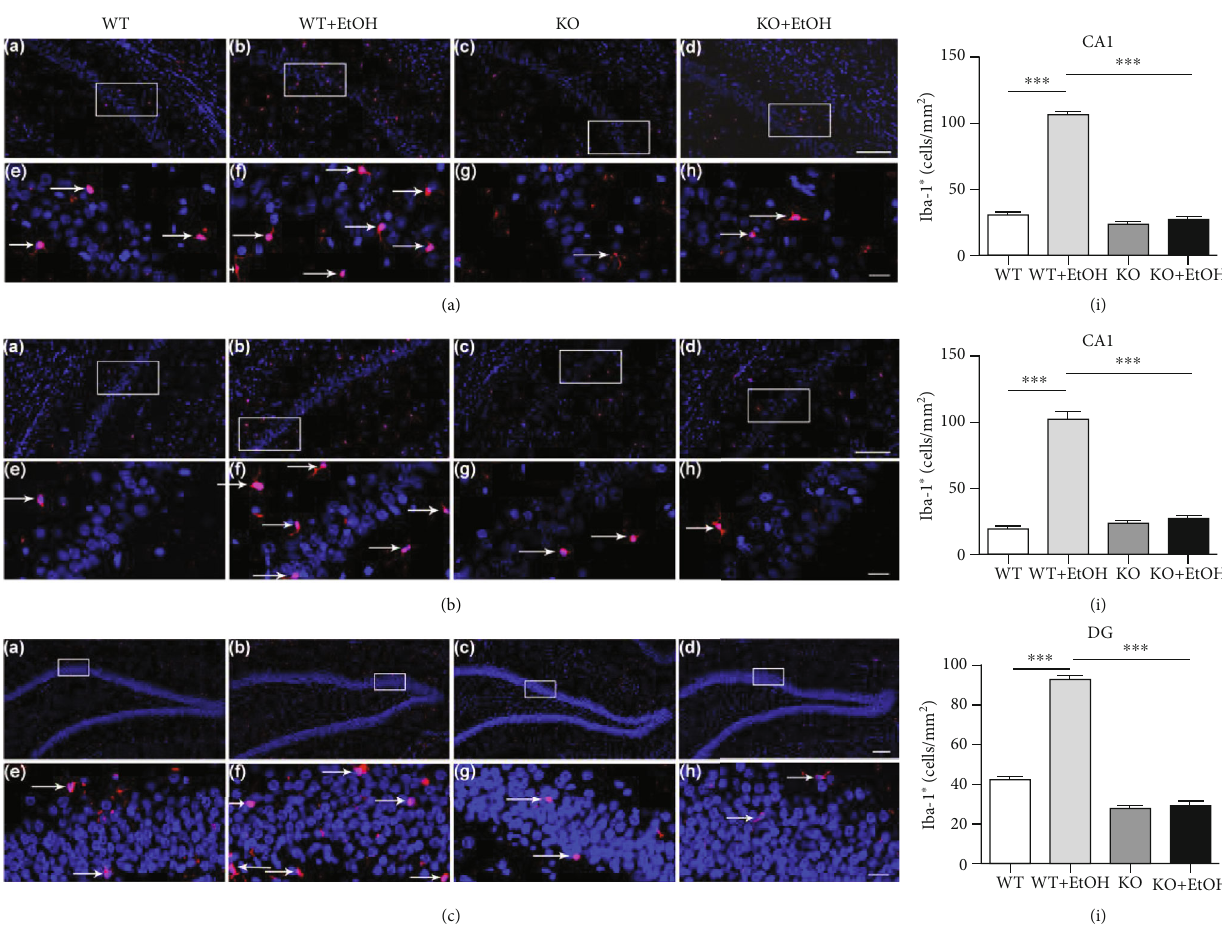
Figure 1: E ff ect of ethanol exposure on the number of microglia (Iba-1 staining) in the hippocampus. Representative photomicrographs of level-matched coronal sections of CA1 (a, A – H), CA2/3 (b, A – H), and DG (c, A – H) from WT (A, E), WT+EtOH (B, F), KO (C, G), and KO +EtOH (D, H) rats. White arrows indicate Iba-1 + microglia. Regions of interest (framed areas) in A – D are presented in E – H. Scale bar: 100 μ m in A – D; 20 μ m in E – H. WT =control rats without ethanol; WT+EtOH =control rats with ethanol; KO =TLR4 knockout rats without ethanol; KO+EtOH=TLR4 knockout rats with ethanol. CA1 = fi eld CA1 of the hippocampus; CA2/3 = fi eld CA2-3 of the hippocampus; DG=dentate gyrus of the hippocampus. Quanti fi cations of Iba-1 + microglia from WT, WT+EtOH, KO, and KO+EtOH rats are shown in (a, I) (CA1), (b, I) (CA2/3), and (c, I) (DG). The number of Iba-1 + microglia was averaged from fi ve random areas across each region in consecutive three sections of each rat. Data are presented as the mean number of Iba-1 + cells/mm 2 ± S : E : M : ( n = 4 ). ∗∗ p < 0 : 01 , ∗∗∗ p < 0 : 001